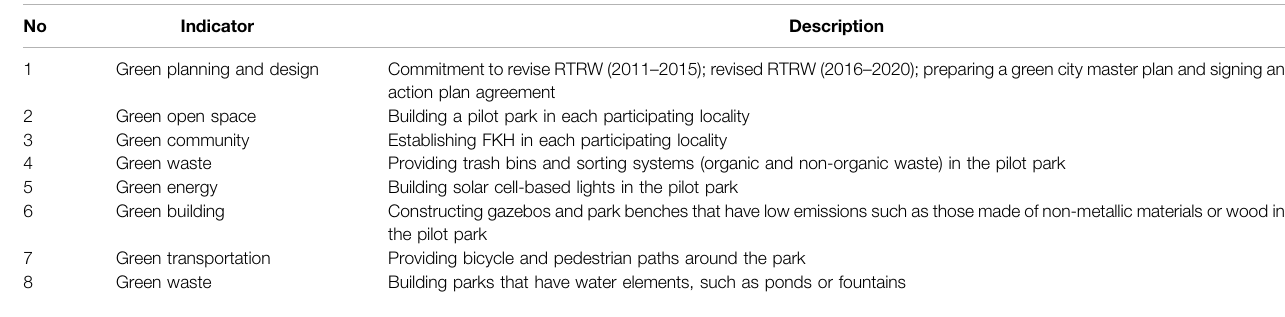
TABLE 3 | Indicators of